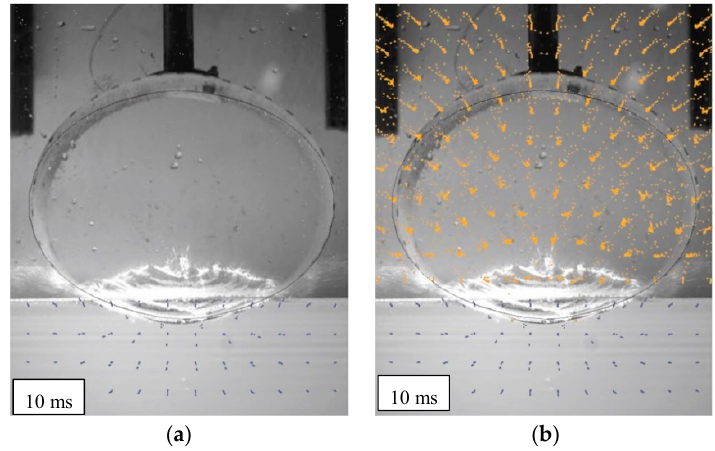
Figure 10. Comparing the effect of air on prediction (drop height of 1500 mm): ( a ) without air; ( b ) with air.